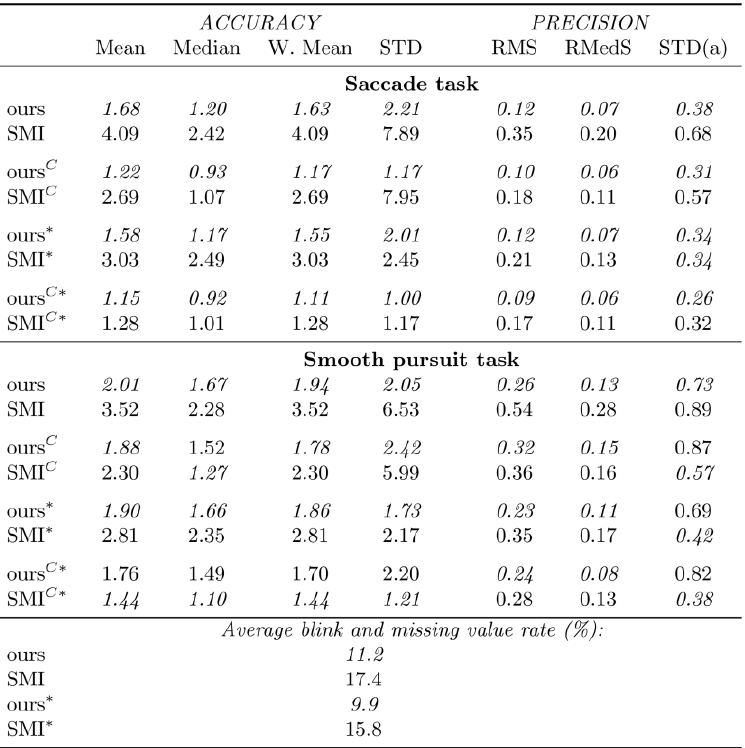
Table 3 . The performance over all test subjects’ data for both the saccade and smooth pursuit tasks, for the presented device (“ours") and the SMI system, in degrees of visual angle. The leftmost column lists the device; next four columns report the mean, median, 𝜔 -weighted mean (see Eq. (37)), and standard deviation (STD) values of accuracy; three rightmost columns report the precision measure which are the average root-mean-square (RMS) and root-median- square (RMedS) values of subsequent angular errors between estimated and target points during fixations or a smooth pursuit movement, and an average standard deviation of the angular errors during a fixation or a separate smooth pursuit movement (STD(a)). Before computing the values, the results from all gaze distances were concate- nated. The superscripts c refer to using data only from the calibration distance and * refer to excluded recordings ID06, ID07, ID11, and ID13 (see Table 1 for explanation). The values at the bottom show the average missing value rate in percentages, that is, the ratio of blinks and unavailable measurements to the number of all events. In each pair of ours and SMI results, the better result is written in italics. Lower values are